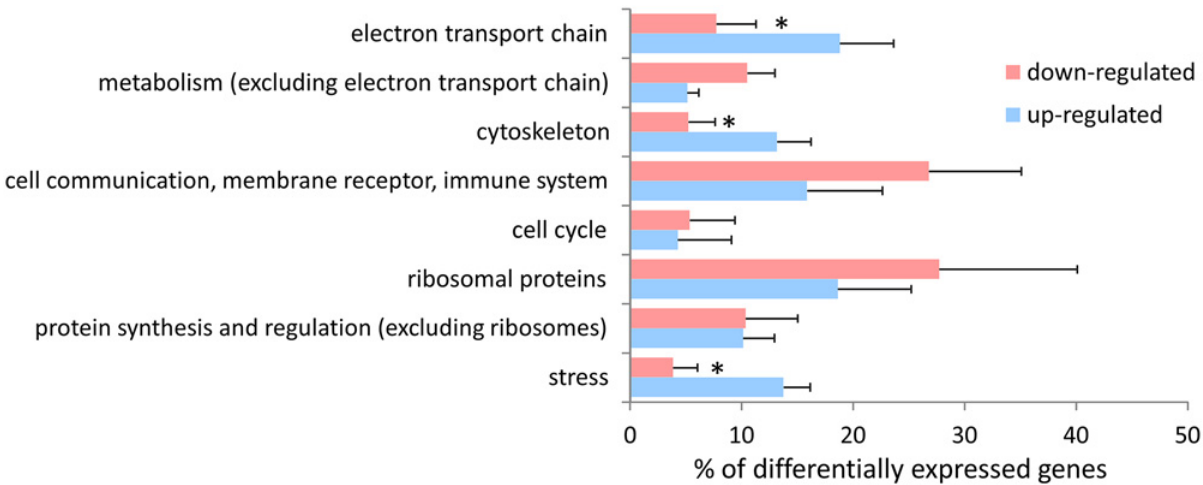
Fig 3. The percentage of genes within discrete intracellular process categories that were reported as either up- or down-regulated by the original authors [6, 13, 15, 18, 20, 21]. Bars = SEM (n = 6 different studies that verifiably reported direction of change), * denotes a significant difference between up- and down-regulation for that category (t-test, p <